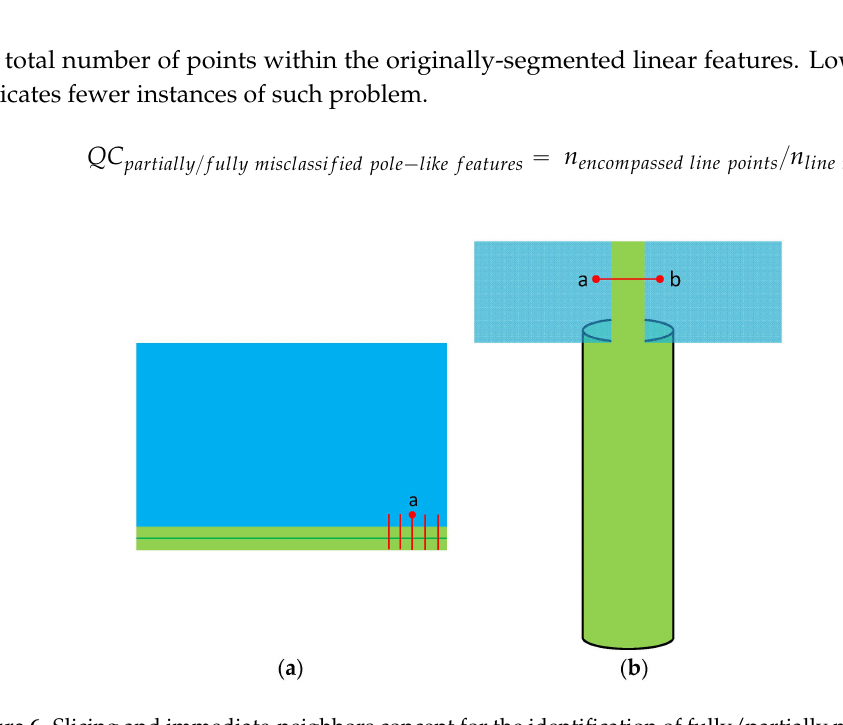
Figure 6. Slicing and immediate-neighbors concept for the identification of fully/partially misclassified pole-like features ( a )/( b